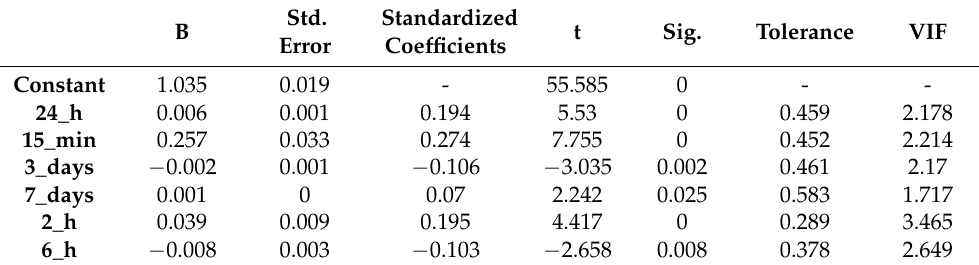
Table 2. OLS regression results for stream stage (dependent variable) with antecedent precipitation depth show that stage is most influenced by rainfall within the prior 15